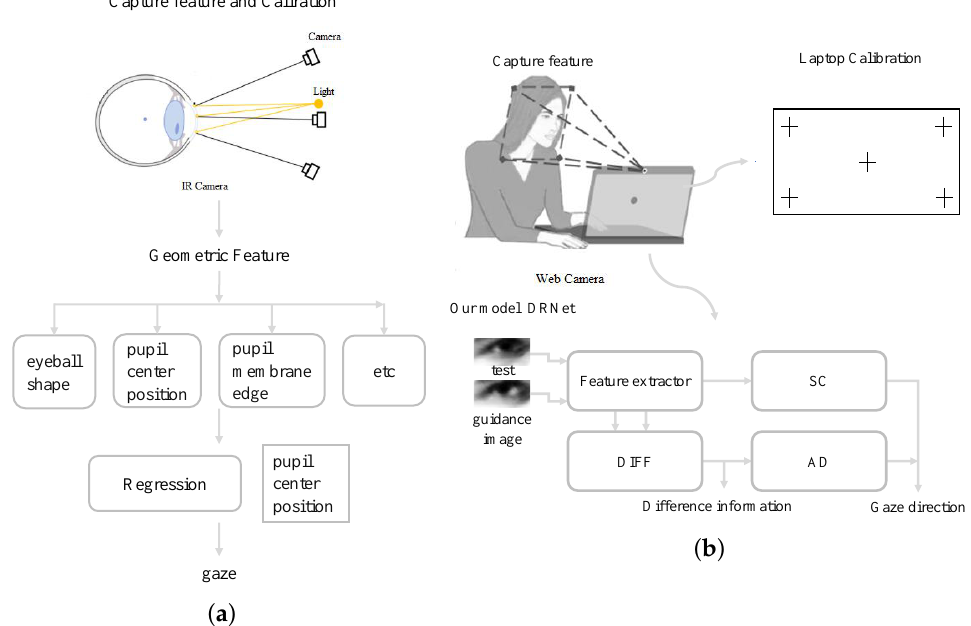
Figure 2. Example of two 3D gaze estimation techniques, ( a ) model-based and ( b ) appearance- based